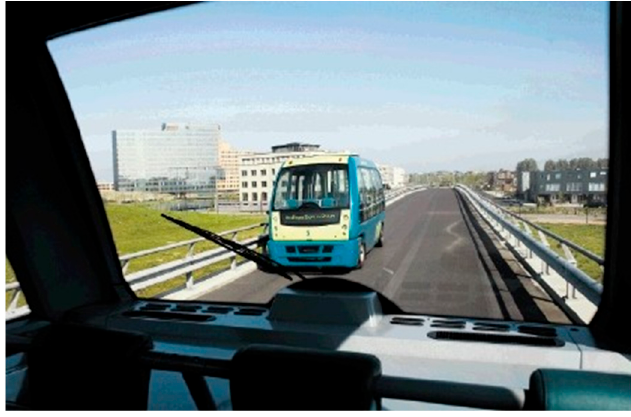
Figure 5. Automated electric ParkShuttle. Reproduced with permission from [14].